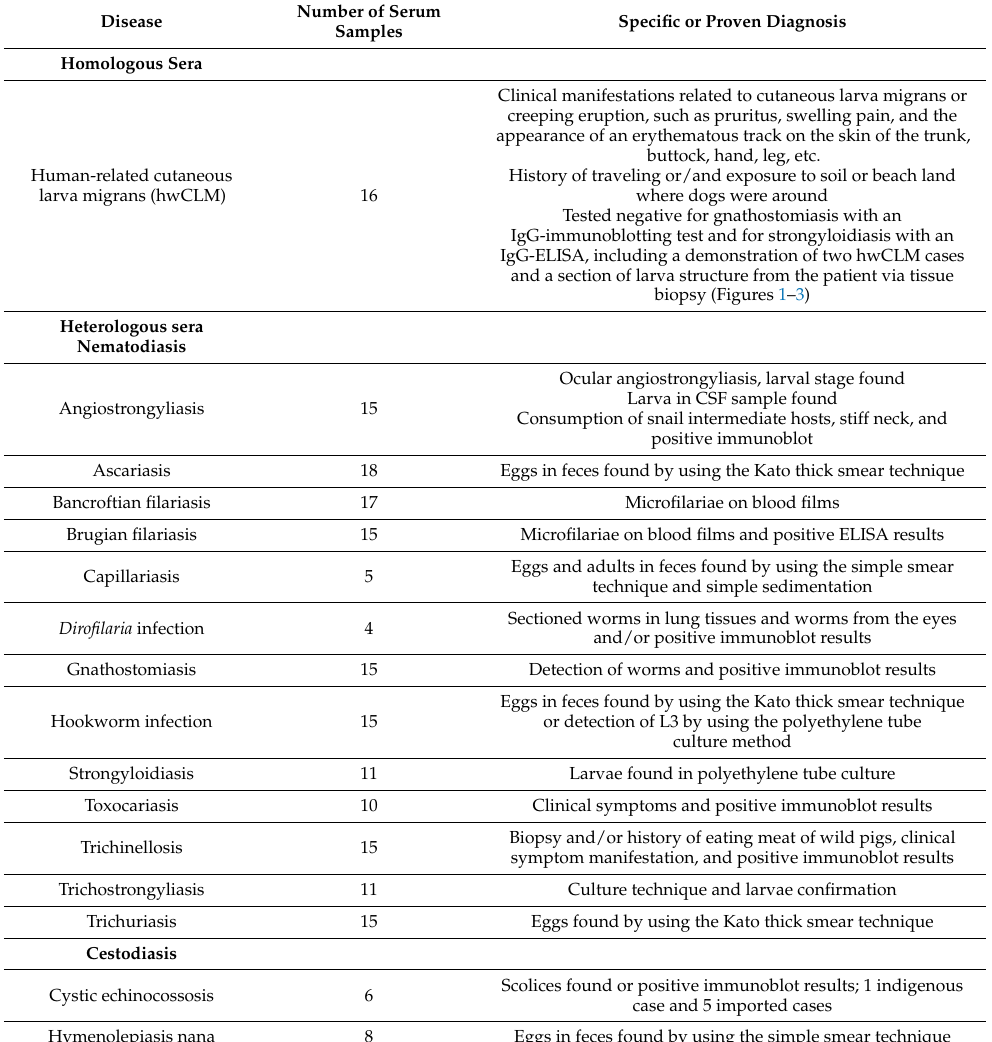
Table 1. Descriptions of serum samples of 27 diseases and from healthy controls using different diagnostic methods, including clinical pictures of hwCLM